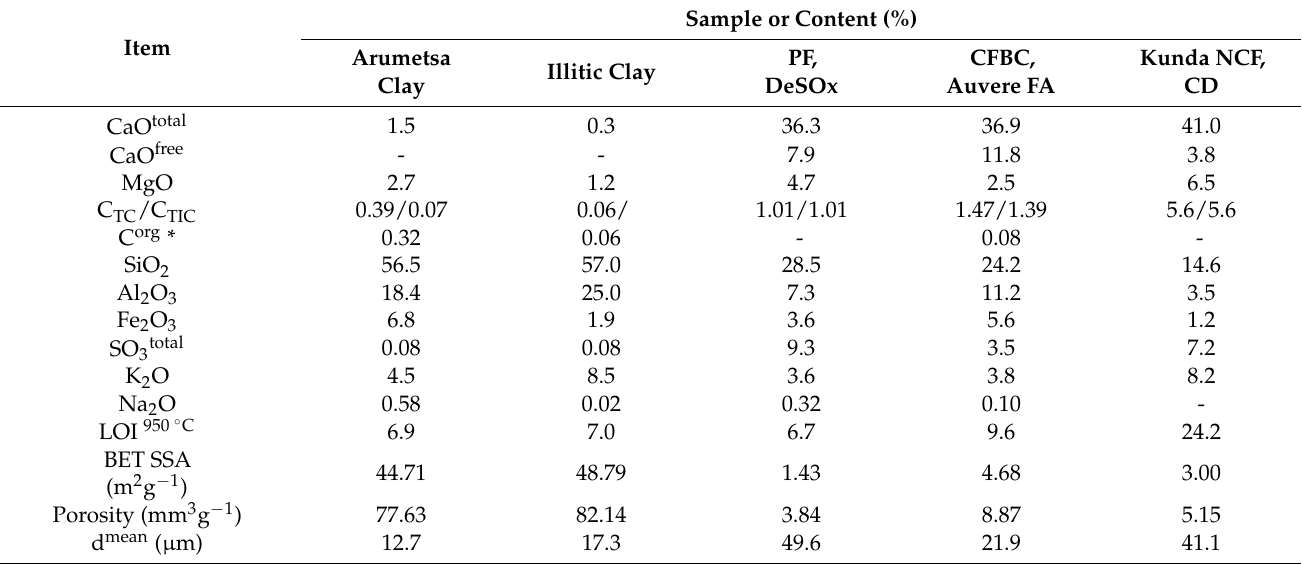
Table 2. Chemical composition (%) and some physicochemical characteristics of initial